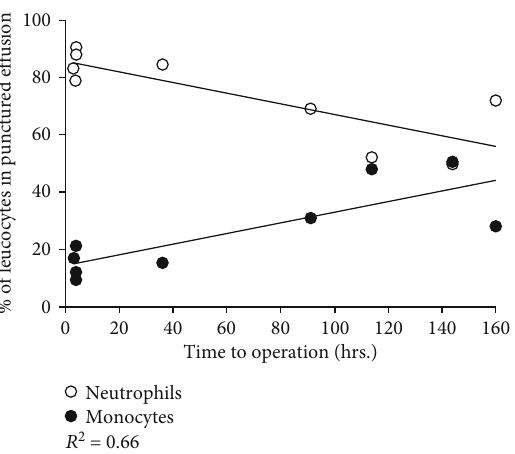
Figure 2: Levels of neutrophils and monocytes in synovial fl uid from ankle fracture patients ( N =8). The neutrophil level increased signi fi cantly ( P =0.008) after injury and decreased again after 7 days ( R value=-0.81), while the monocyte level shows the opposite changes ( R value=0.81).